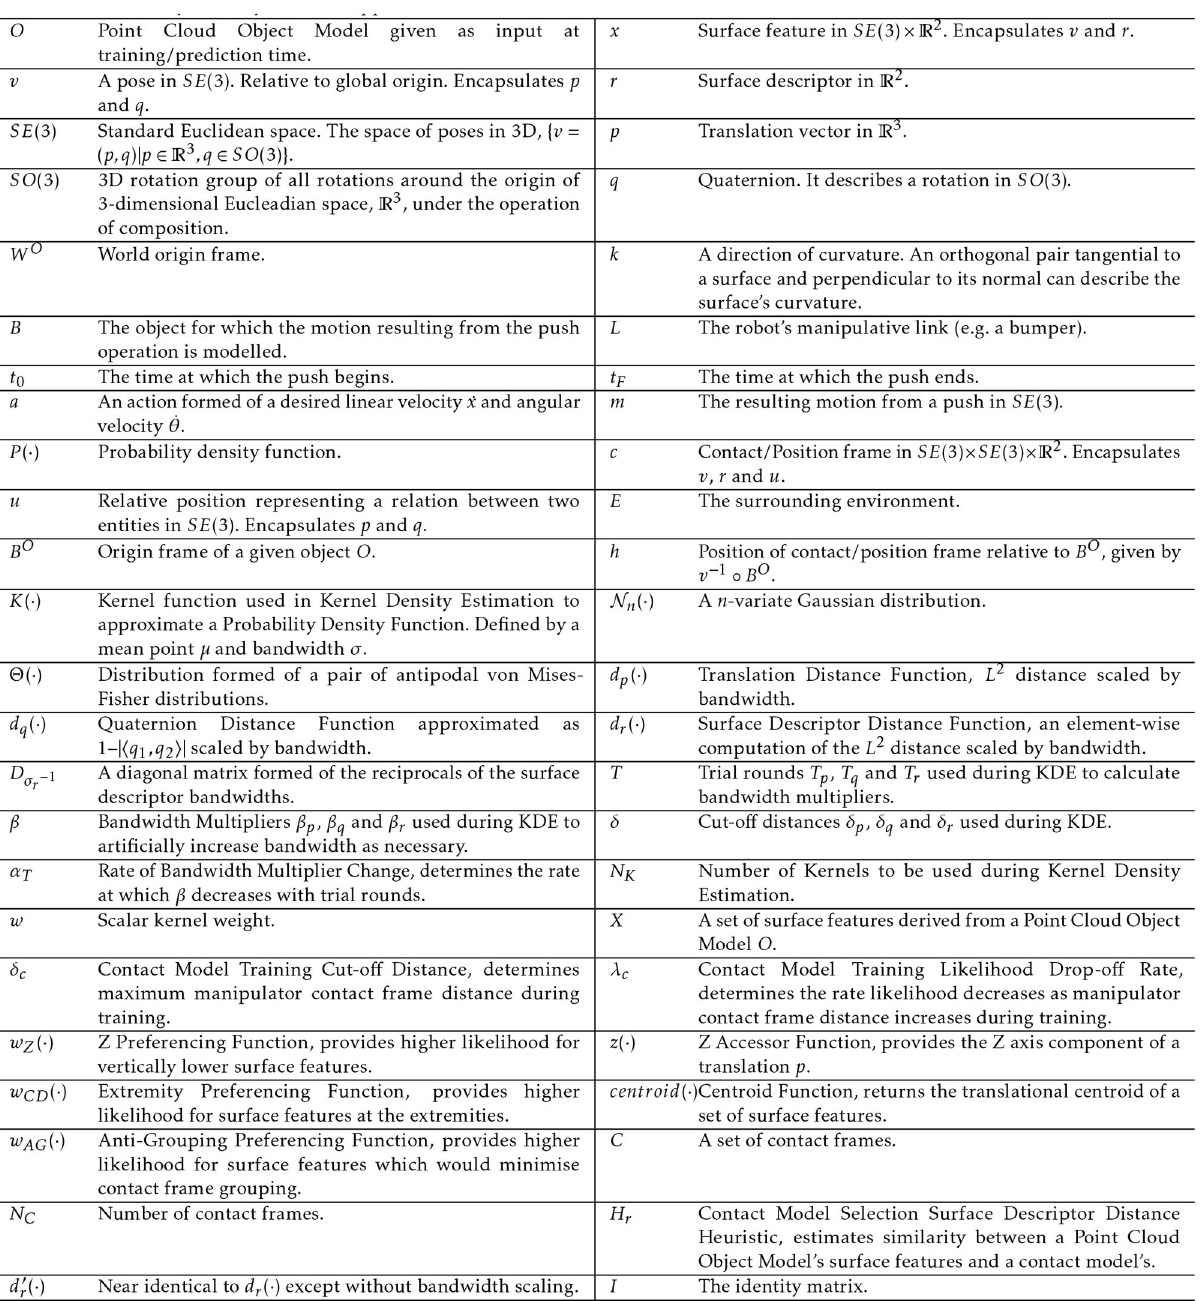
TABLE 1 | List of symbols by order of